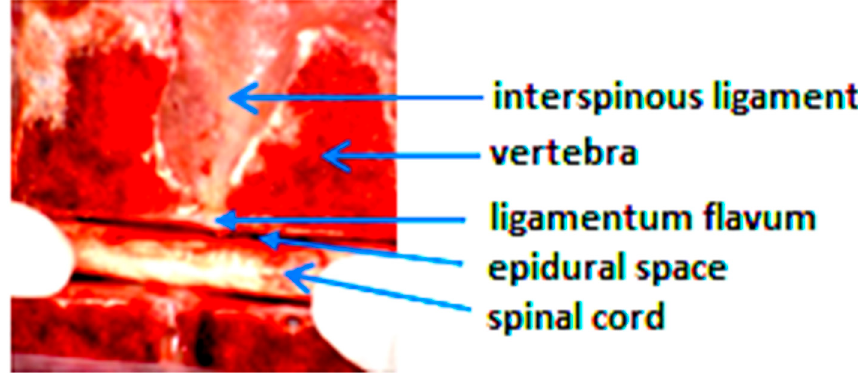
Figure 1. A piece of fresh trunk pork including vertebra. Skin and fat layers are not